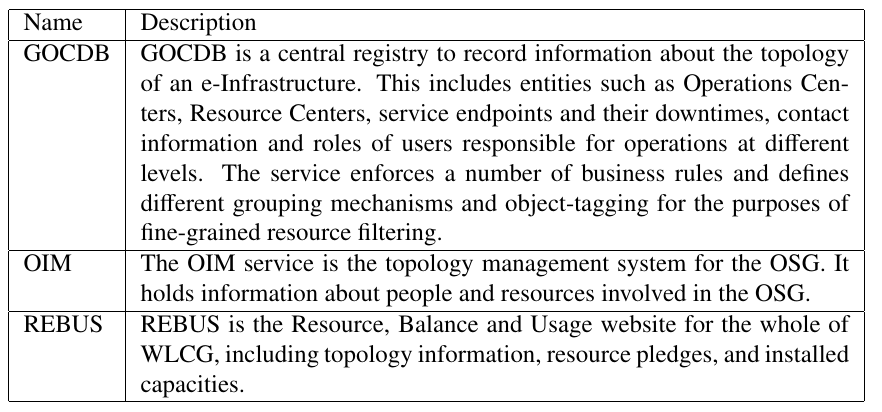
Table 1. Examples of information sources used by